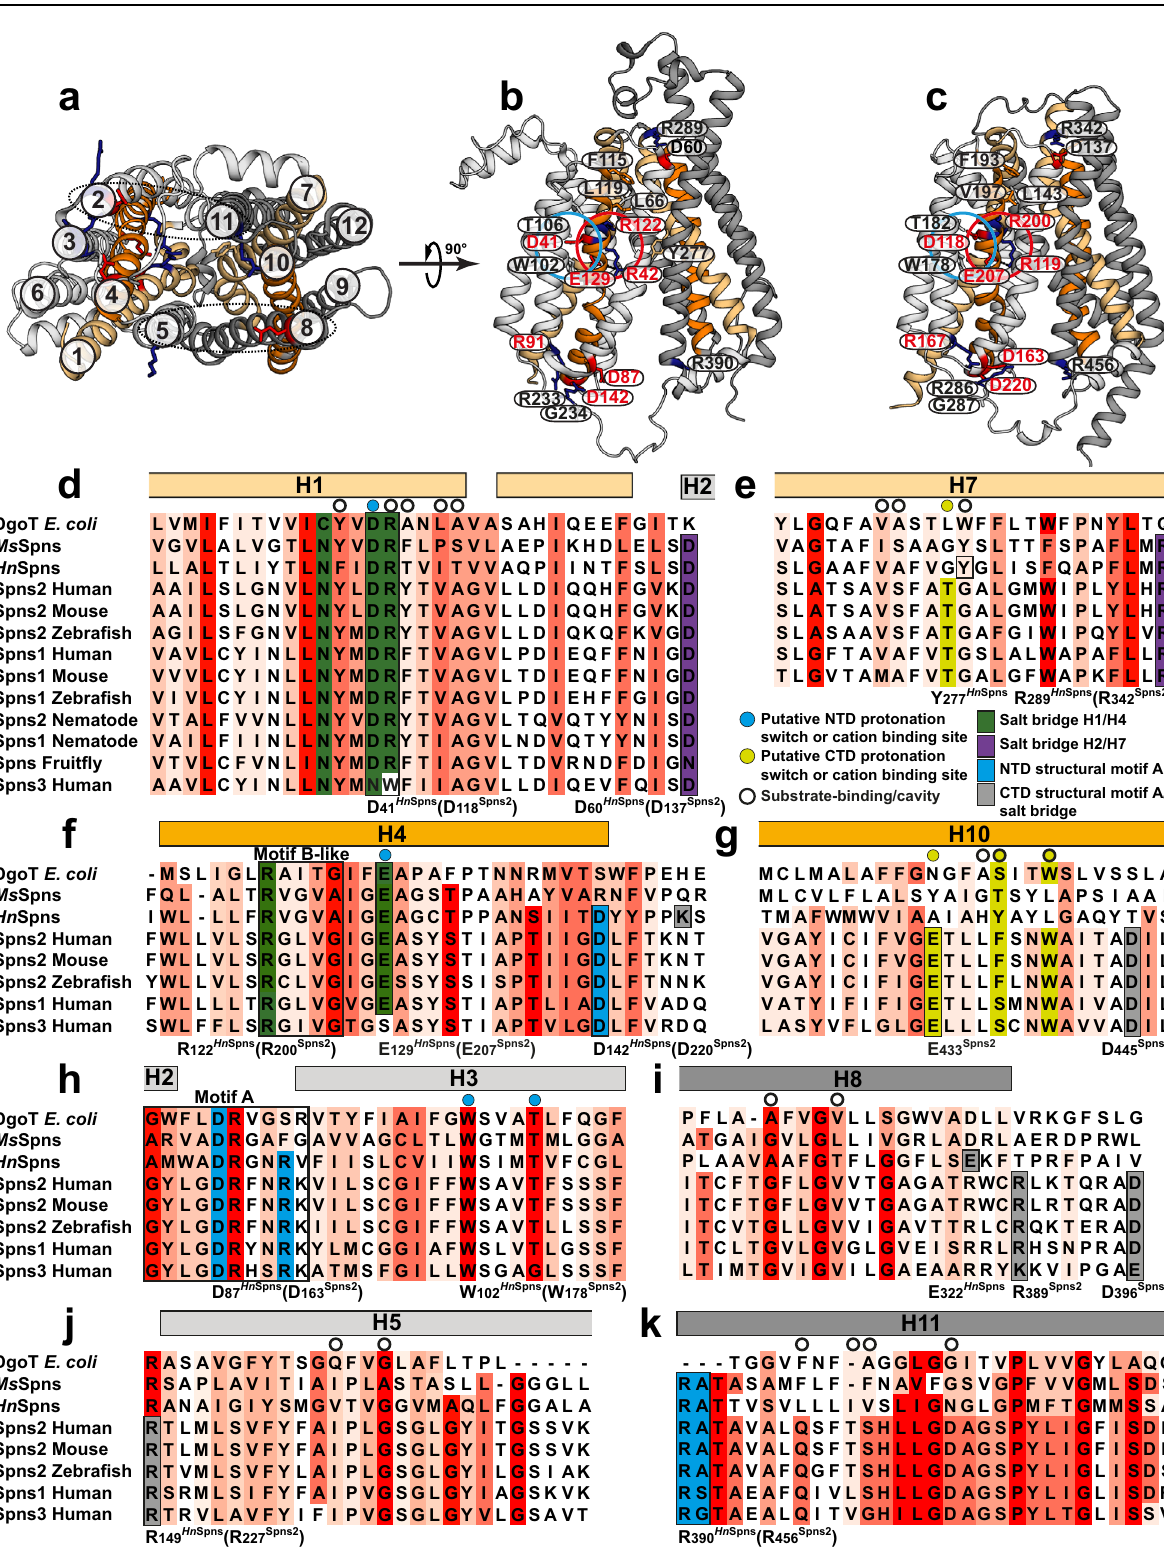
d – k Sequence alignment of Spns proteins and their bacterial homologs, the M. smegmatis MDR transporter ( Ms Spns), and the E. coli MFS homolog DgoT. The putative substrate and cationbinding site residues are marked by circles. Residues are colored according to sequence conservation with different shades of red. Functional residues are colored